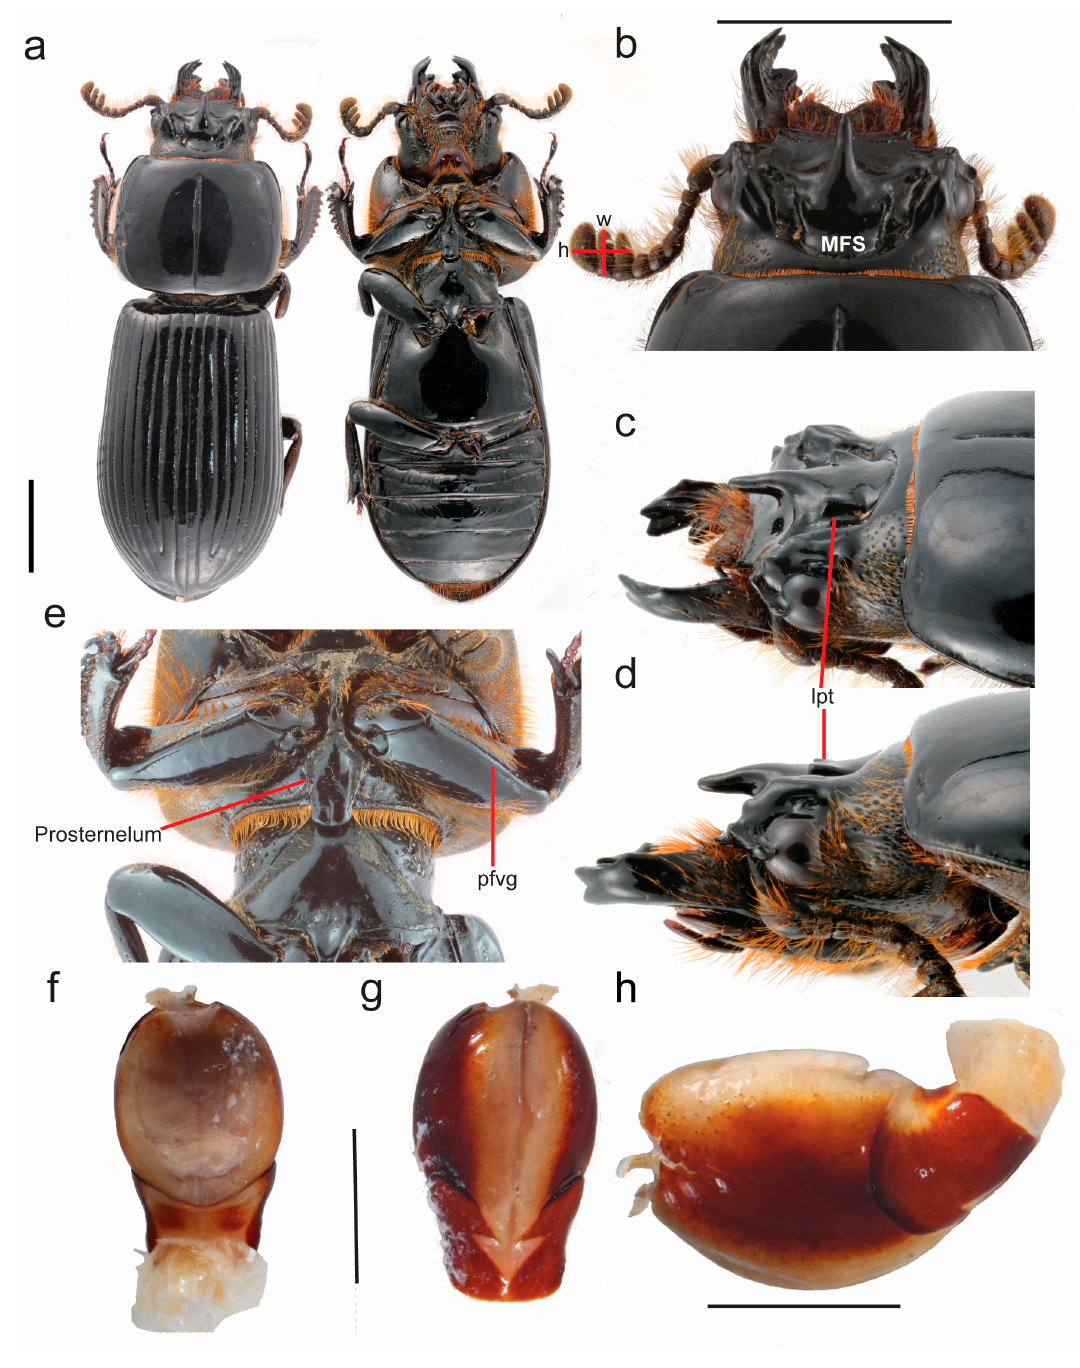
Figure 3. Tonantzin tepetl n. sp. ( a ) Habitus, dorsal and ventral views. Head views: ( b ) dorsal; ( c ) oblique; ( d ) lateral. ( e ) Prothorax, ventral. Aedeagus: ( f ) dorsal; ( g ) ventral; ( h ) lateral. Scale bars: 5 mm (3a–3d); 1.5 mm (3f–3h). Labels: MFS = mesofrontal structure, lpt = latero-posterior tubercles, pfvg = profemur ventral grove. a–e (allotype); f–h (paratype).